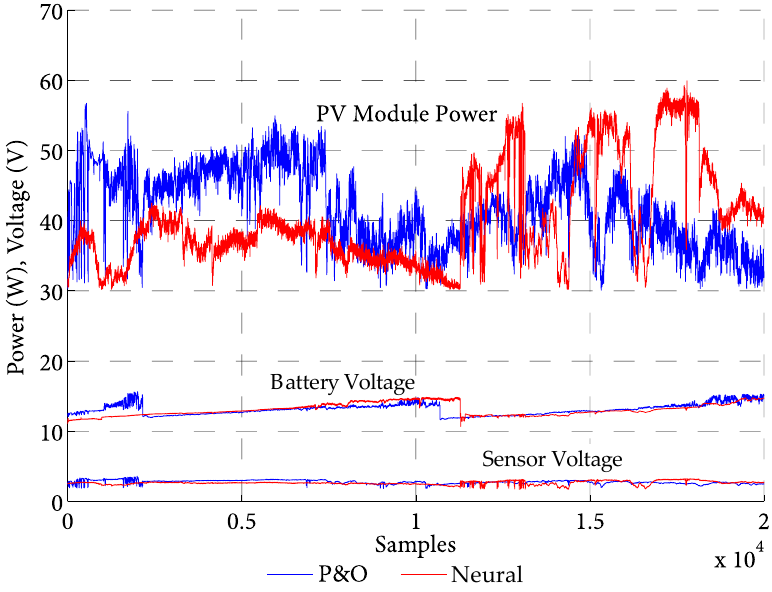
Figure 24. Implementation results for the neural controller and Perturb and Observe (P&O) algorithm.